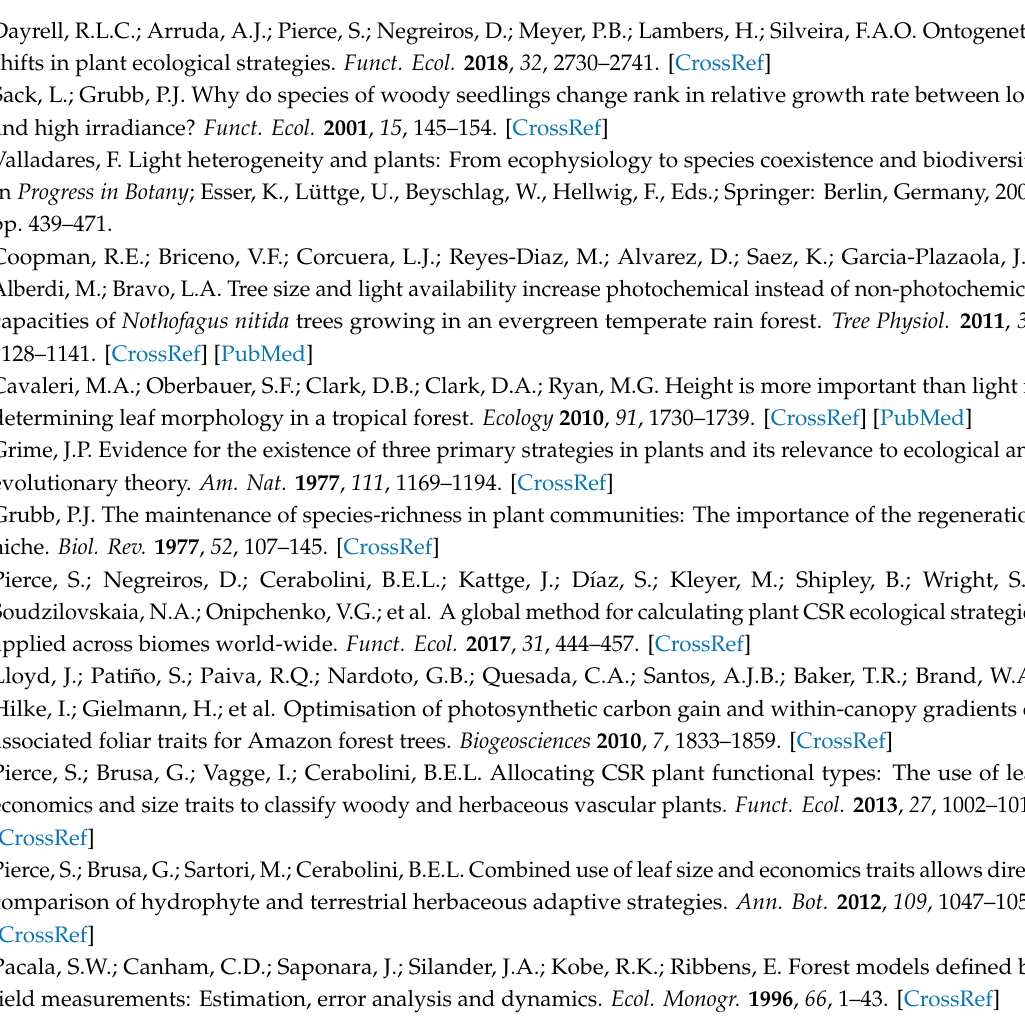
Figure S1: Simple linear regression result for R d_area ’ vs. R d_area . The solid line indicates the simple linear regression result: R d_area ’ = − 0.1210 + 1.0337 × R d_area , r 2 = 0.889, F = 161.6, P < 0.01, Table S1: Species list of the 1.44 ha (120 m × 120 m) canopy crane plot in Xishuangbanna, Southwestern China. This list was based on survey data collected in December 2014 and includes all tree species with DBH ≥ 1 cm, Table S2: Linear piecewise regression results for traits ( y ) vs. height (x). The following regression models were used: Equation (1): y = a 1 + b + b × x, x < transition point; Equation (2): y = a × x, x ≥ transition point, Table S3: Linear piecewise 1 2 2 regression results for traits (y) vs. light (represented as ln(%TRANS), x). The following regression models were Quadratic regression results for traits (y) vs. height or ln(%TRANS) (x). The following regression model was